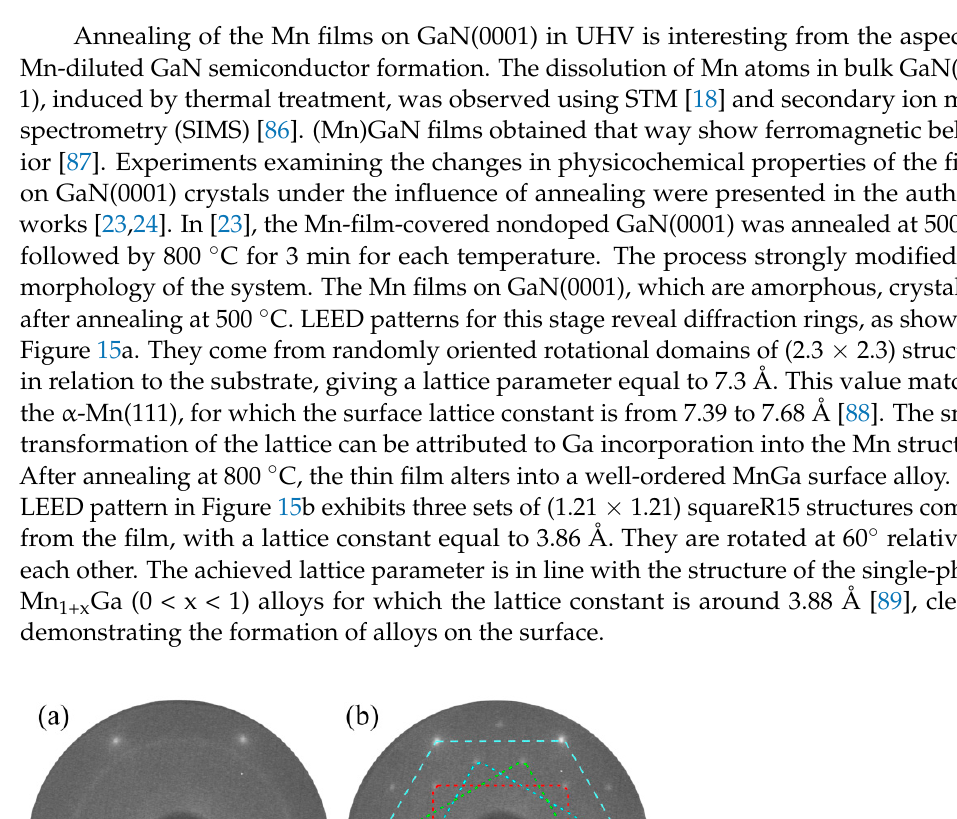
demonstrating the formation of alloys on the surface.